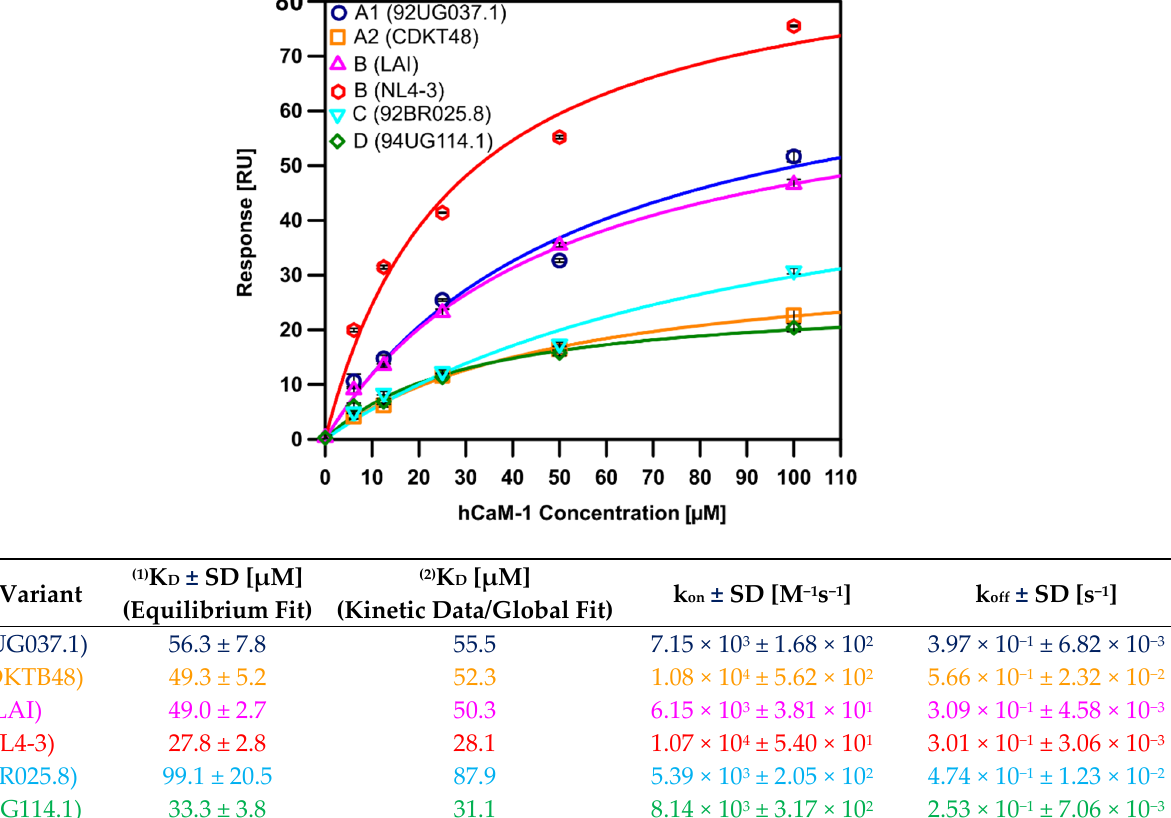
Figure 3. Binding isotherms of hCaM-1 to immobilized full-length HIV-1 MA from clade A1, A2, B, C, and D, and the corresponding kinetic parameters in the table below. Binding isotherms are derived from the data in Figure 2. Experiments were performed in triplicate and data displayed with standard deviations (SD). (1) Equilibrium Dissociation Constant (K D ) derived from a Langmuir isotherm equilibrium fit or (2) from a global fit and the derived kinetic data. A1 (92UG037.1), A2 (CDKTB48), B(NL4-3), B(LAI), C (92BR025.8), and D